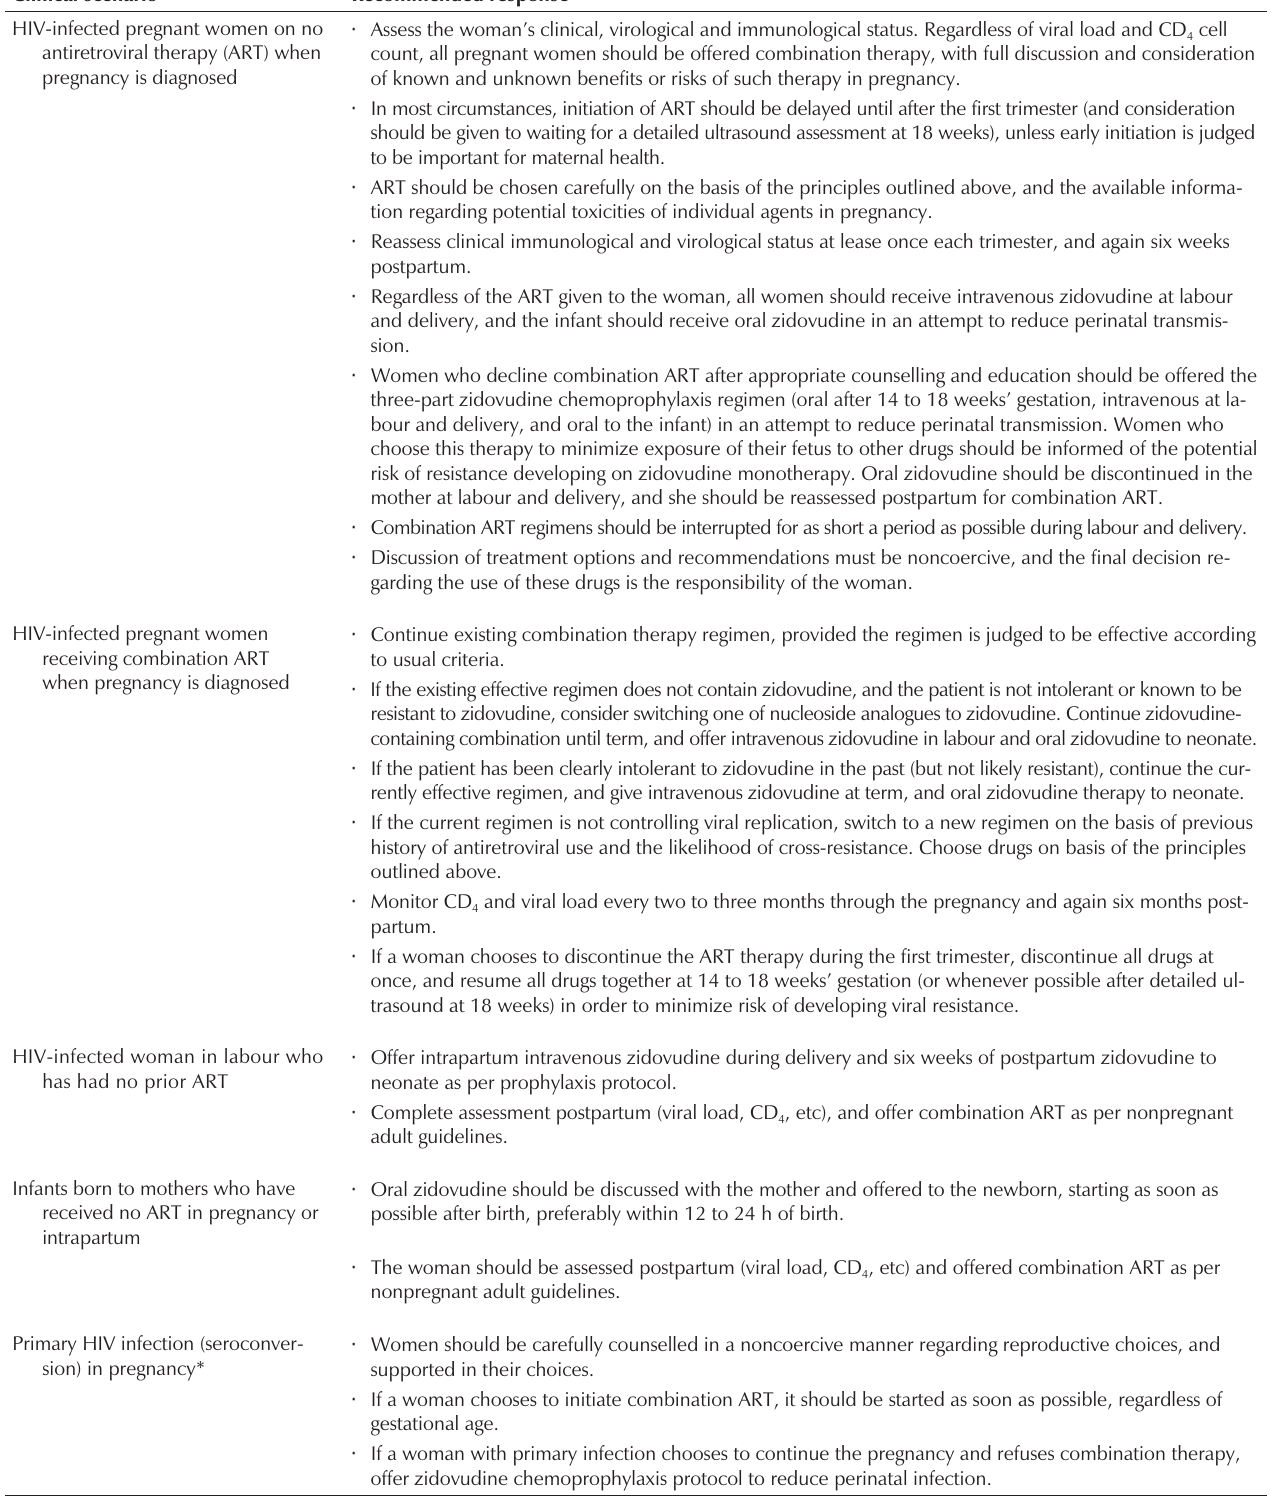
TABLE 2 Clinical scenarios Clinical scenario Recommended